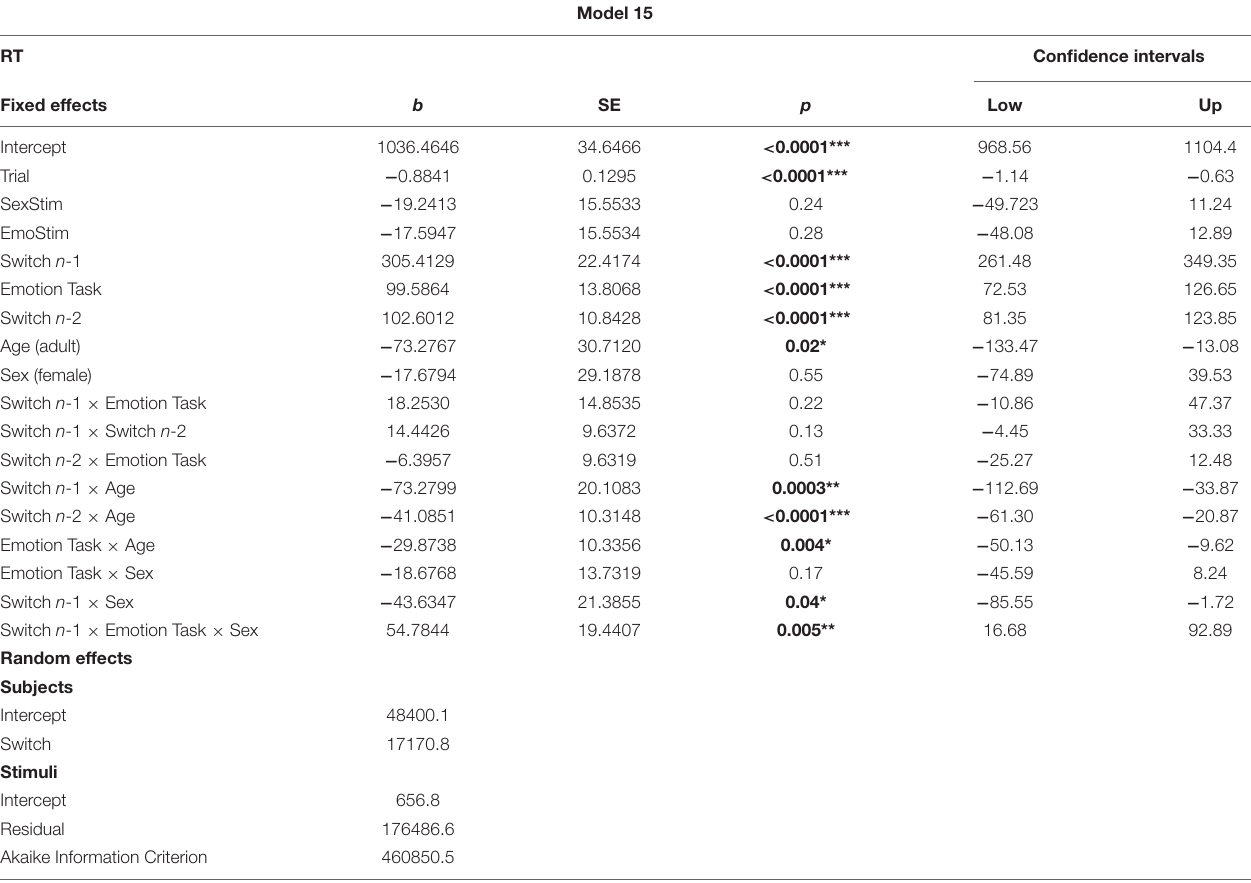
TABLE 5 | Linear Mixed Model results for final model